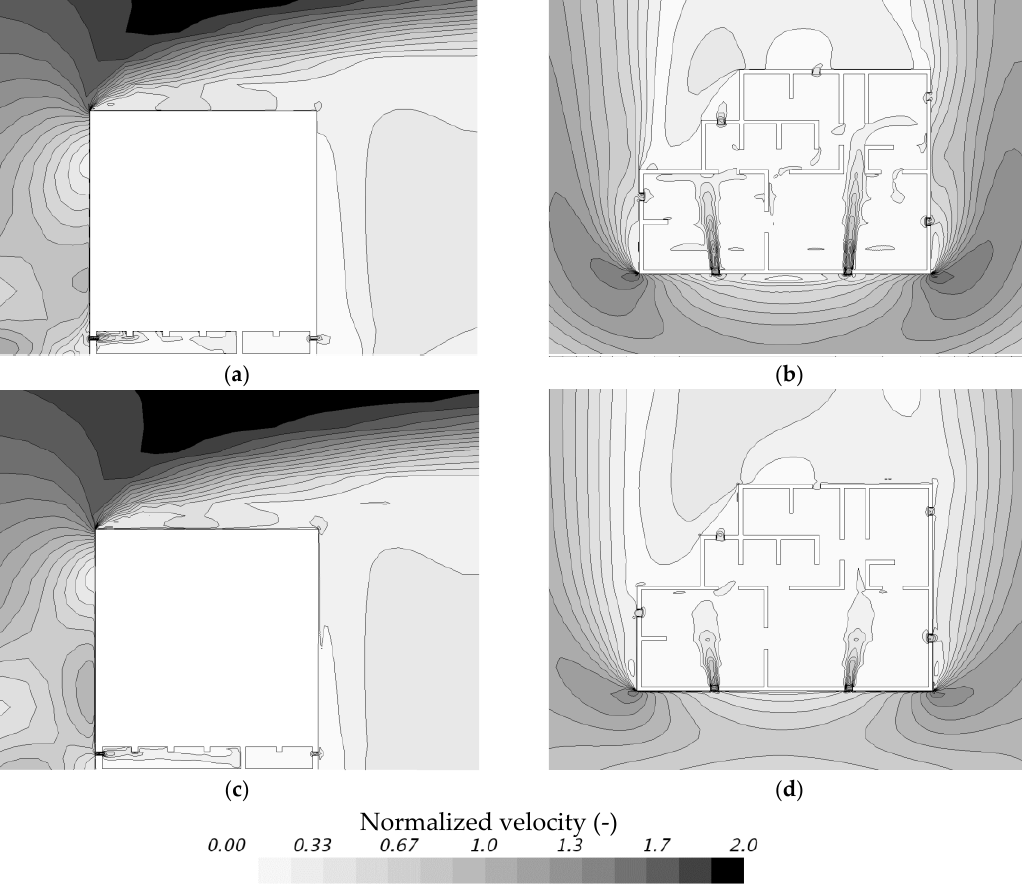
Figure 6. The normalized velocity U distribution of around the building and inside of the underfloor U o 1/4 = ( z ) U o h space in condition of U z velocity profile: ( a ) Scalar velocity distribution in section IJKL, where the velocity condition U 0 (h) is 1.0 m/s; ( b ) Scalar velocity distribution in section MNOP, where the velocity condition U 0 (h) is 1.0 m/s; ( c ) Section velocity distribution on section IJKL, where the velocity condition U 0 (h) is 0.05 m/s; ( d ) Section velocity distribution on MNOP, where the velocity condition U 0 (h) is 0.05 m/s.